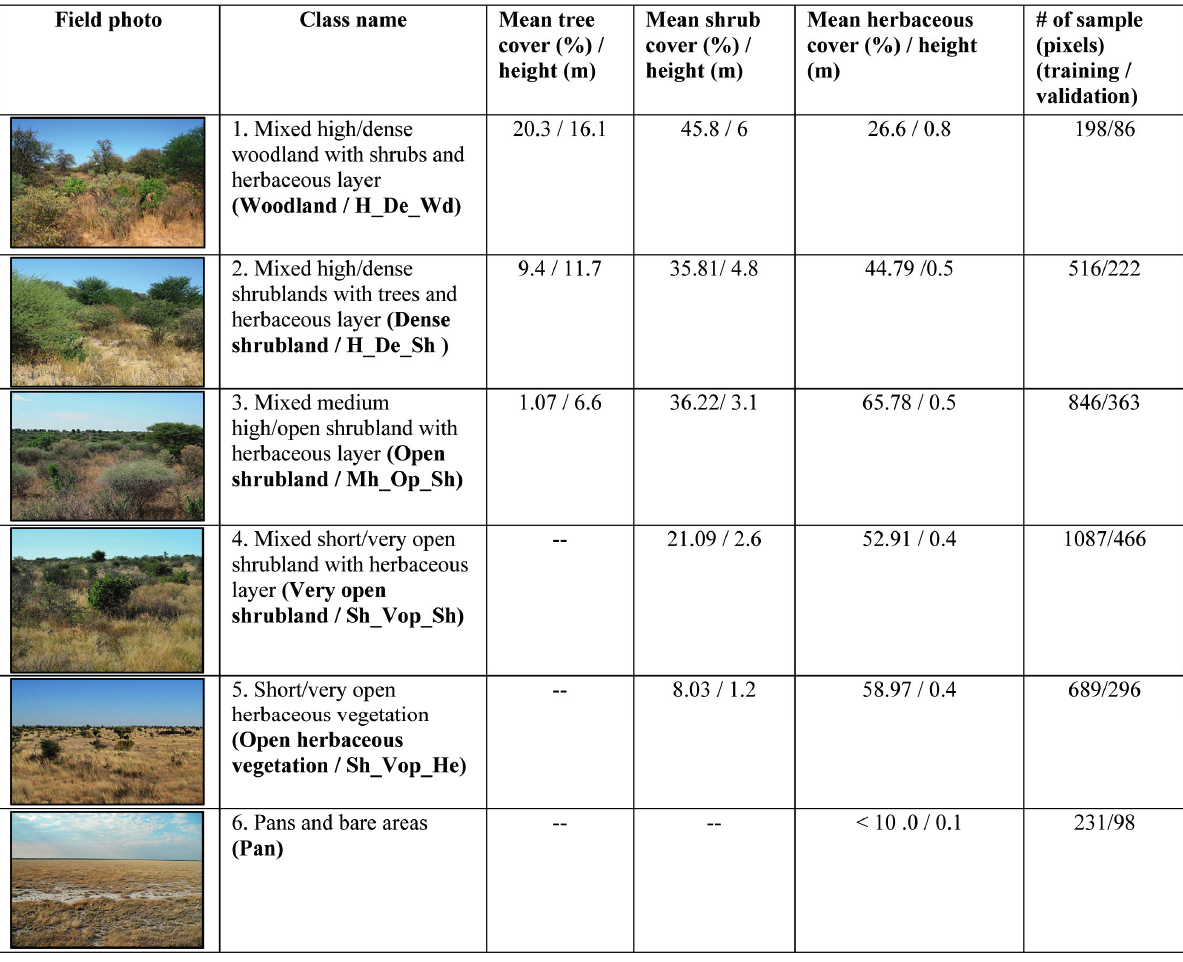
Figure 2. Different vegetation morphology types and their physiognomic characteristics considered in this study as derived from field